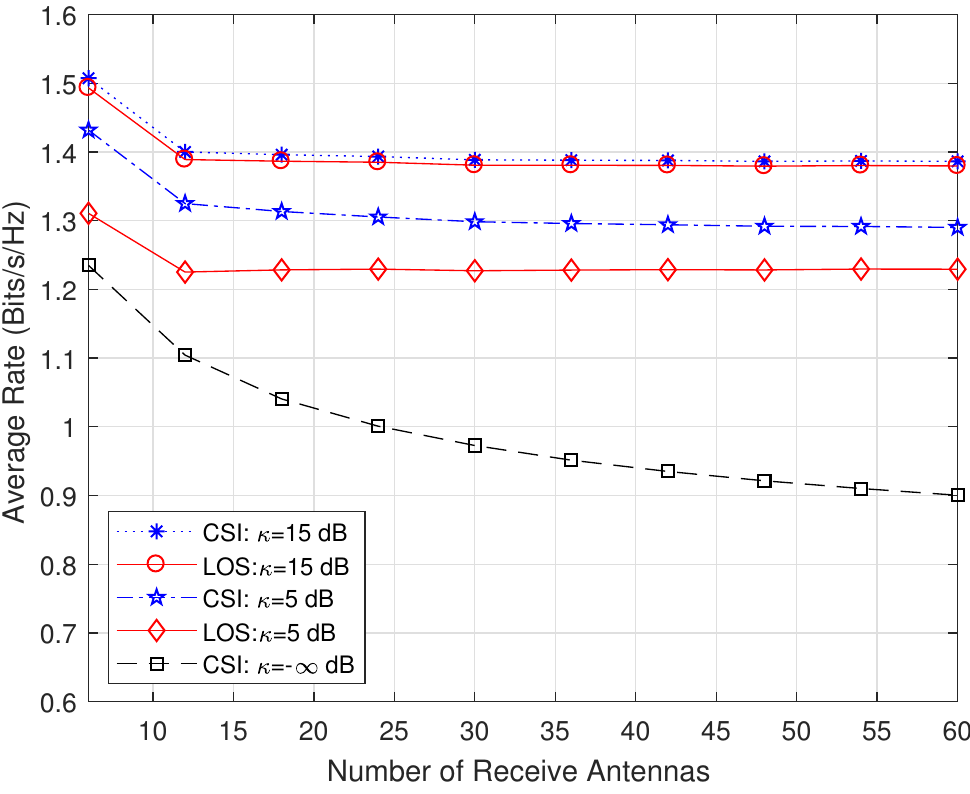
Figure 3. The ergodic achievable rate versus the number of relay antennas for comparing the case with Ricean fading and the case with Rayleigh